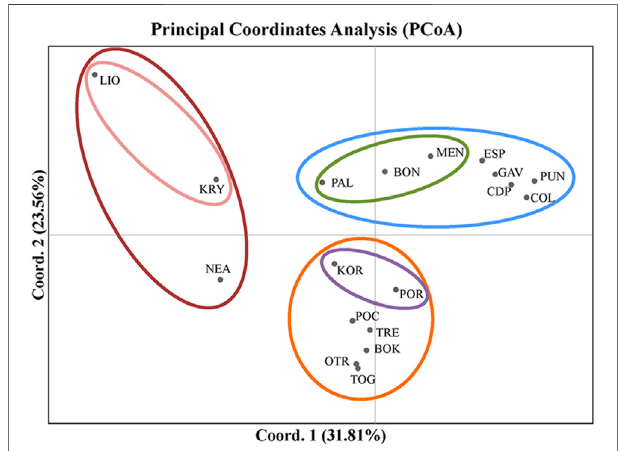
FIGURE3| ResultsofthePrincipalCoordinatesAnalysis(PCoA)usedto detect clustering of the populations of C. caespitosa on the basis of F ST values. The fi rst axis explains 31.8% of the variation, and the second, 23.56% of the variation.